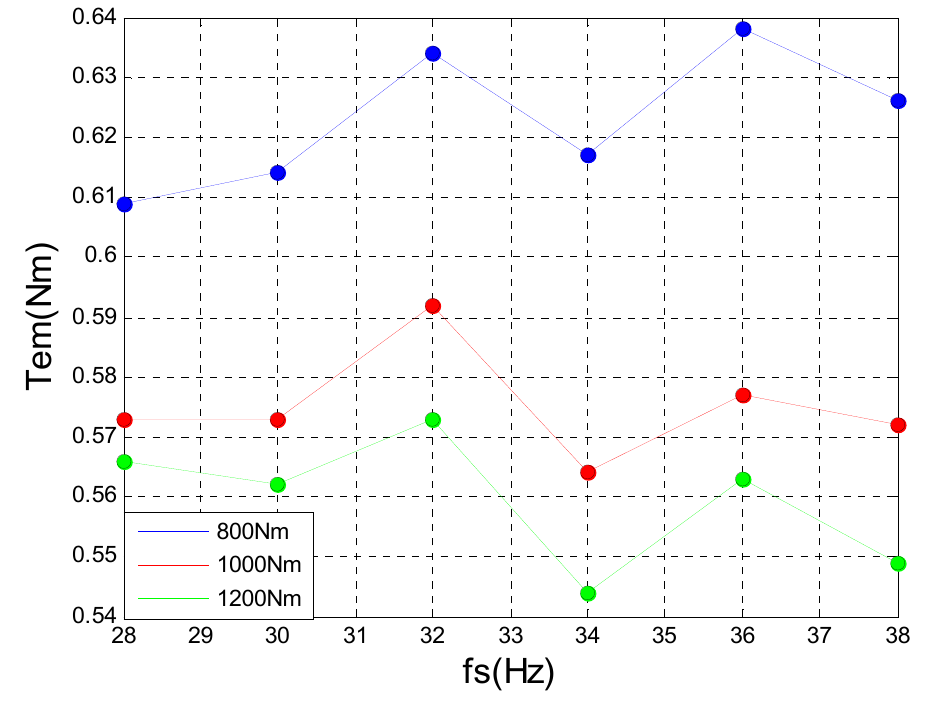
( b ) Figure 6. DC current during the injection. ( a ) “a” phase. ( b ) “b” phase.